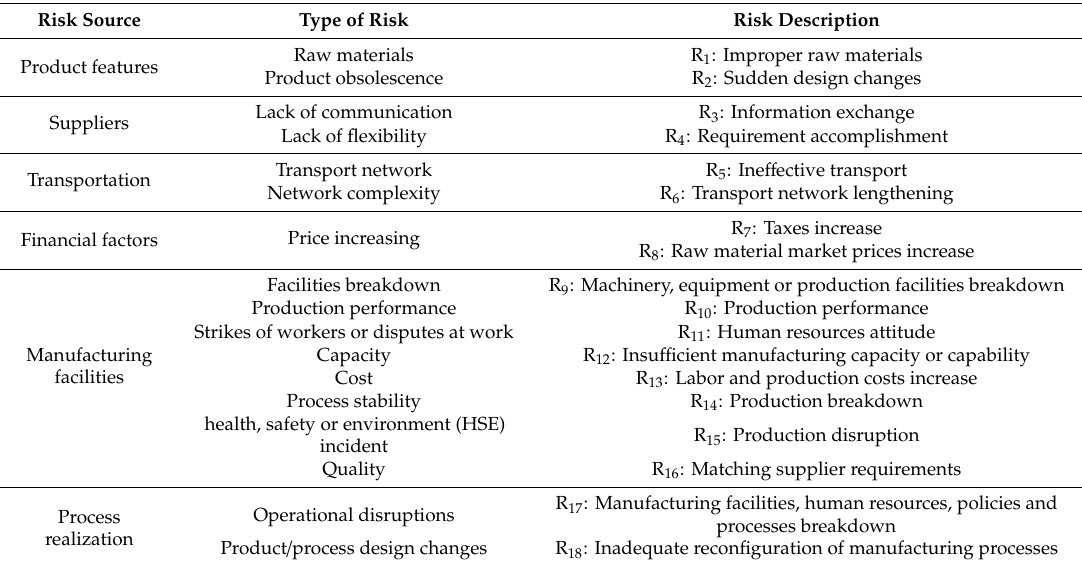
Table 2. SCR identification for the automotive